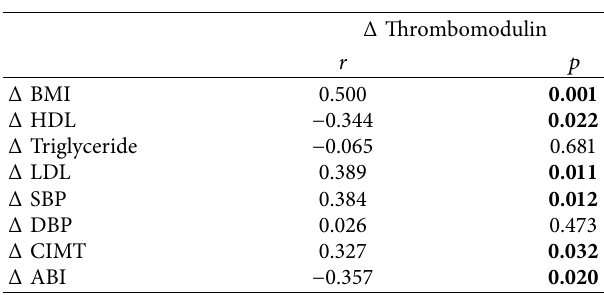
HDL and thrombomodulin Δ Δ